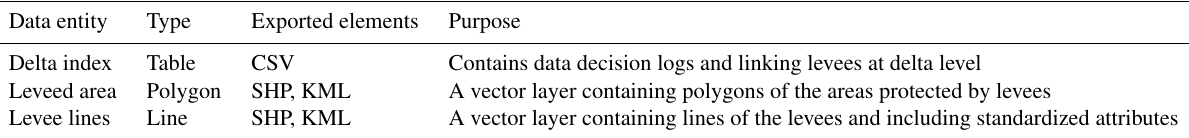
Table 1. Data entities in the live viewing environment and their exported file types as in the research data store. Data entity